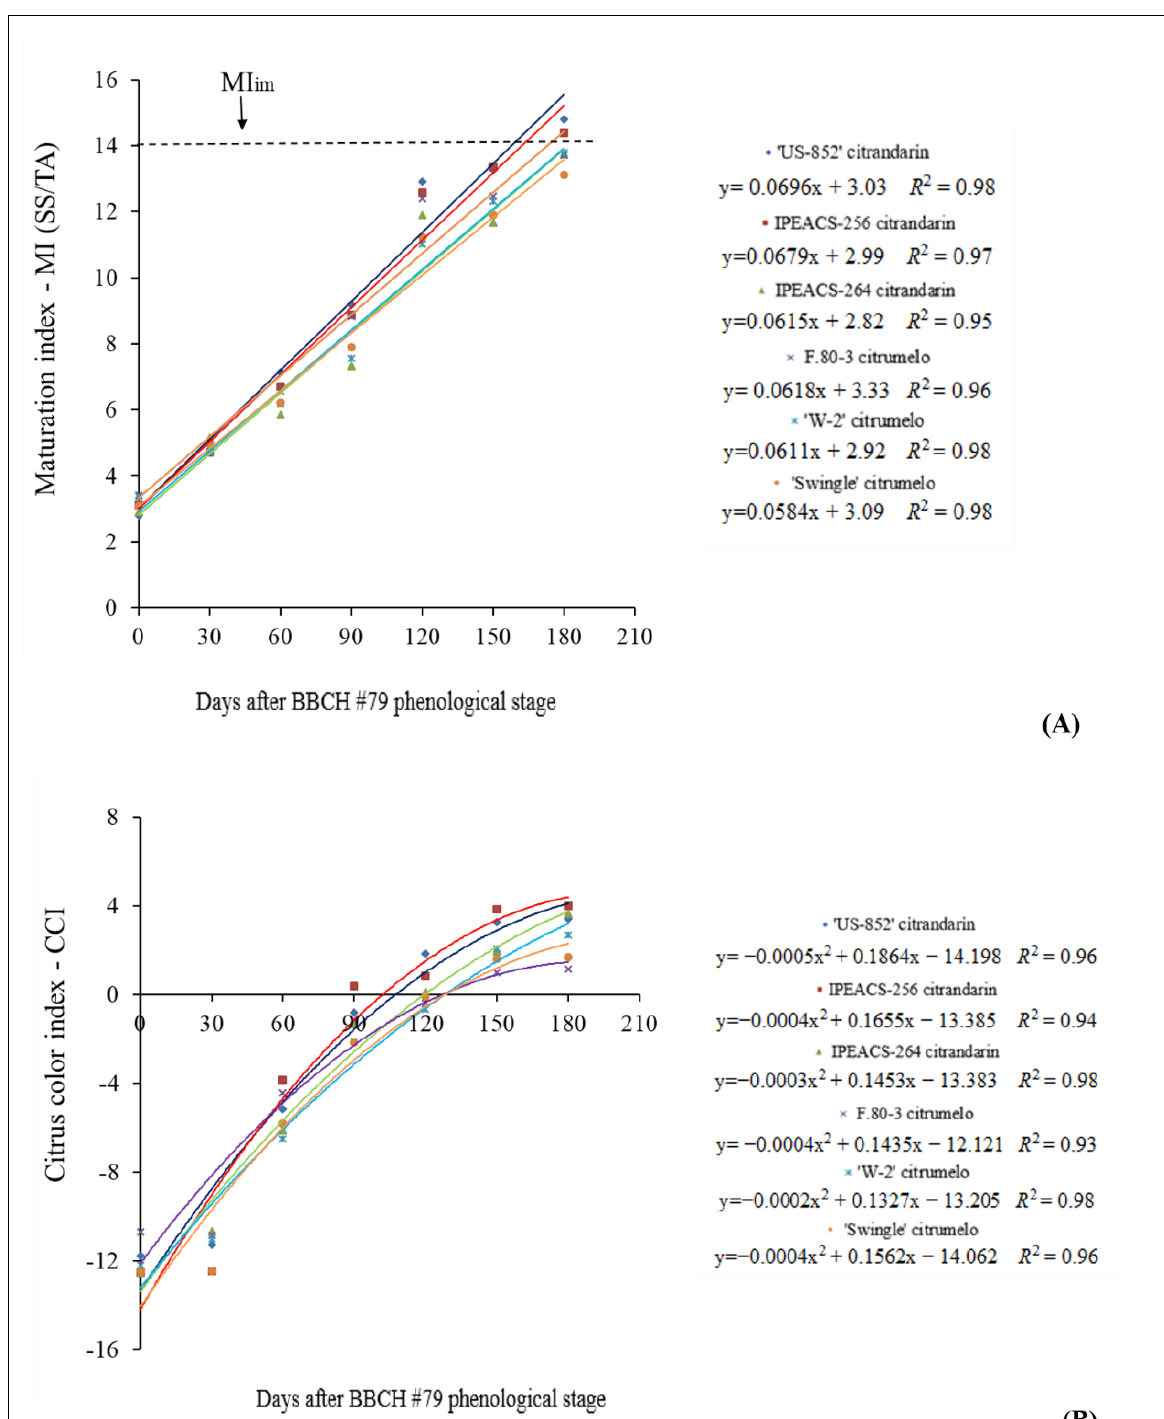
Figure 3. Development of ‘Valencia’ orange fruit ripening when trees are grafted on different ‘Trifoliata’ hybrid rootstocks at Rancho Alegre. ( A ): maturation index (Mi) or ratio (SS/TA); ( B ): citrus color index (CCI). MI im = ideal mean maturation index = 14. Phenological stage BBCH #79 (Meier, 2001), approximately to 200 days after flowering.